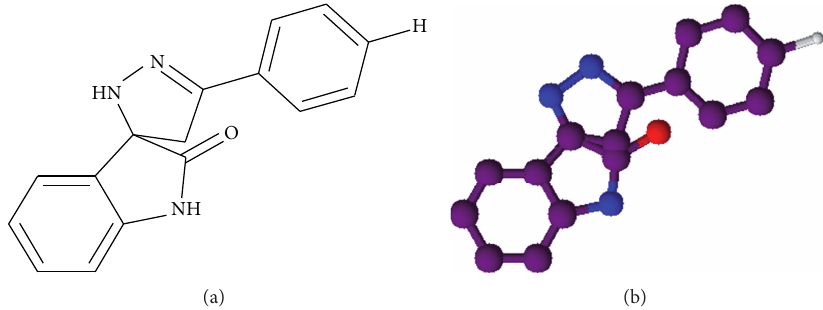
F 1: Molecular structure of 5